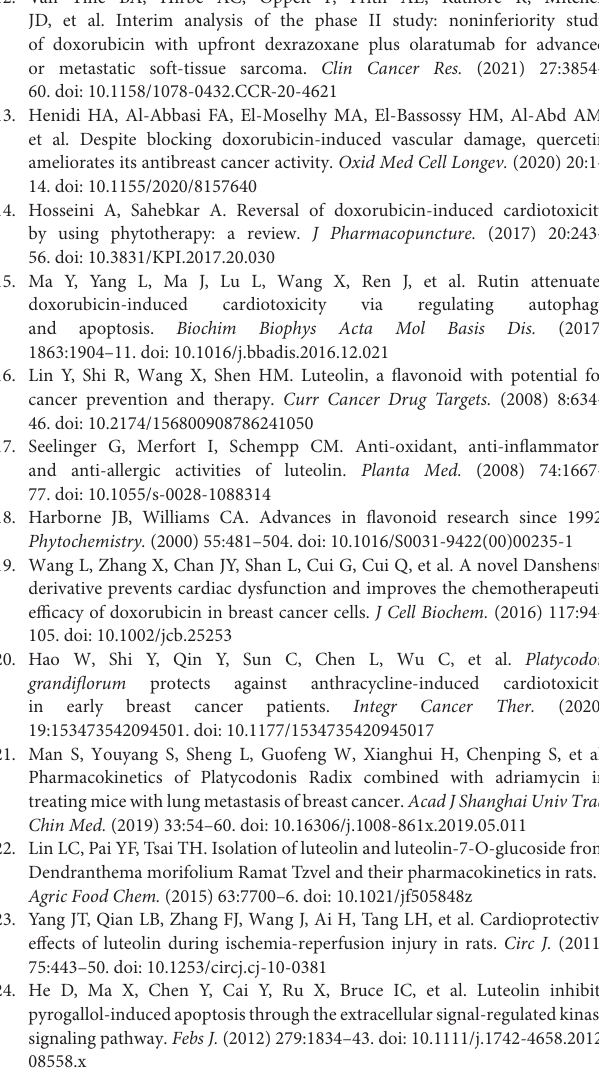
Supplementary Figure 1 | (A,B) Representative TUNEL staining depicting H9c2 and AC16 cell apoptosis after Dox and Lut treatment (200 × ). White arrows show positive cells. Supplementary Figure 2 | Echocardiographic assay was used to determine the attenuated cardiac structure of Lut on Dox-induced cardiac dysfunction in